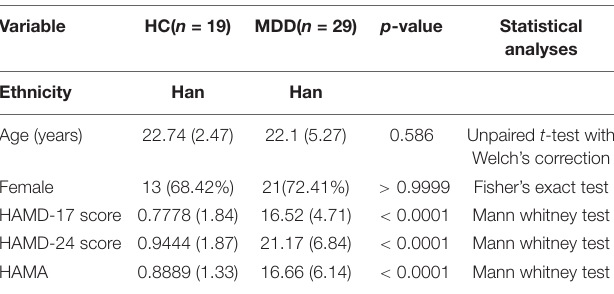
TABLE 1 | Clinical characteristics of MDD patients and healthy